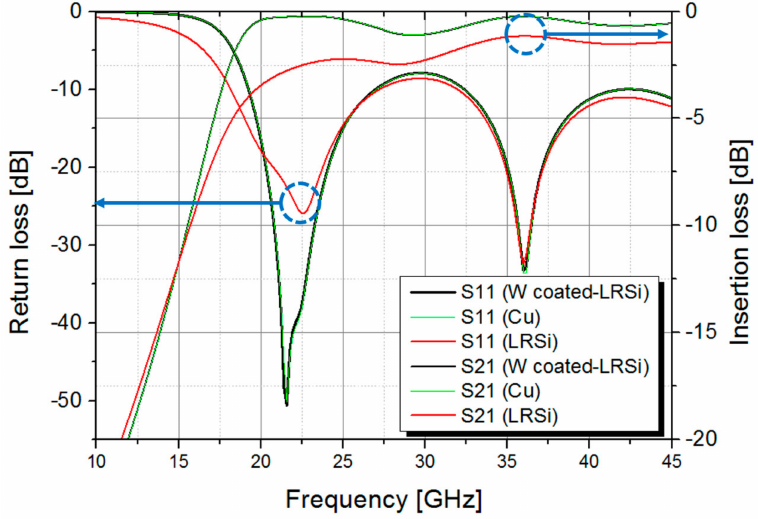
Figure 2. Simulated S -parameters of the SIWs with three different via structures: tungsten-coated low-resistive silicon, copper, and pure low-resistive